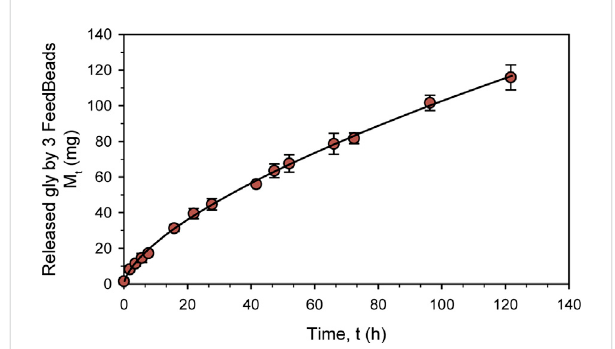
FIGURE 1 Characterization in shake- fl ask of three FeedBeads ® releasing glycerol at 25 ° C inBM. The dots indicate thereleased glycerol amount measured by HPLC, while the line describes the release kinetic. The error bars indicate the standard deviation between